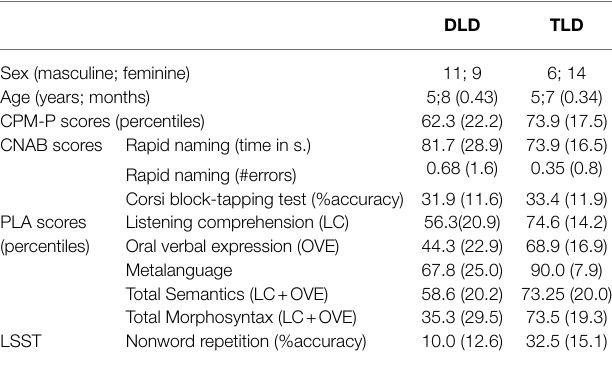
TABLE 1 | Descriptive (Frequencies, Means, and SDs—in brackets) of the characteristics of the children in the developmental language disorder (DLD) and typical language developmental (TLD)